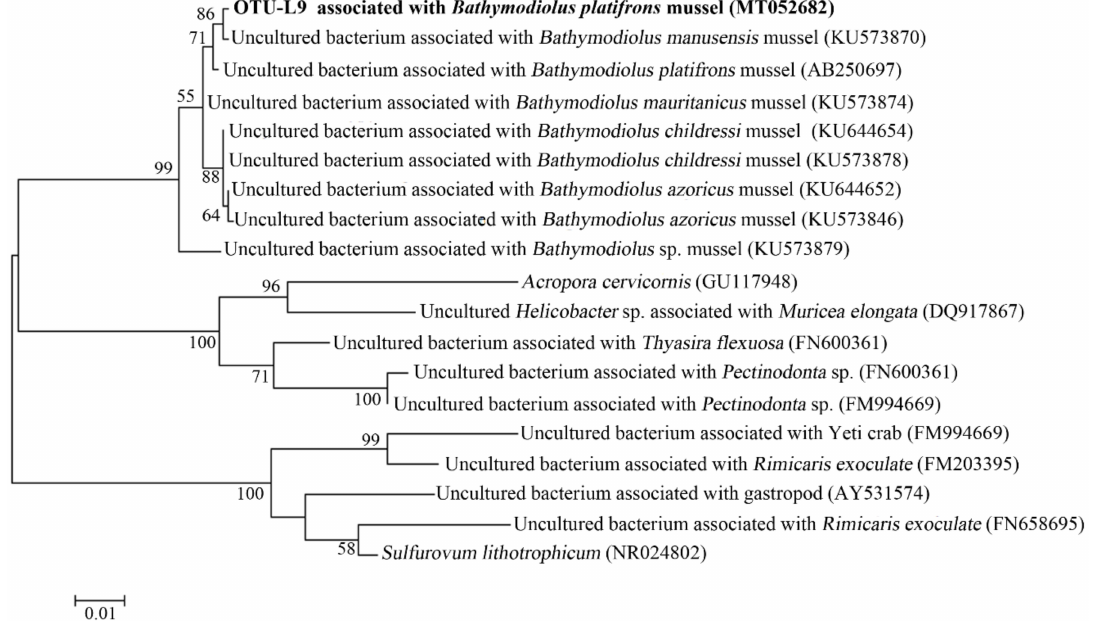
Figure 9. The maximum-likelihood phylogenetic tree based on nearly complete 16S rRNA gene sequences (1417 bp) showing the position of OTU-L9 from this study. Close sequences from NCBI database were selected to construct the tree. GenBank accession numbers are shown in parenthesis. Only bootstrap values (expressed as percentages of 1000 replications) equal or greater than 50% are shown at the branching points. Scale bar, 0.01 substitutions per nucleotide